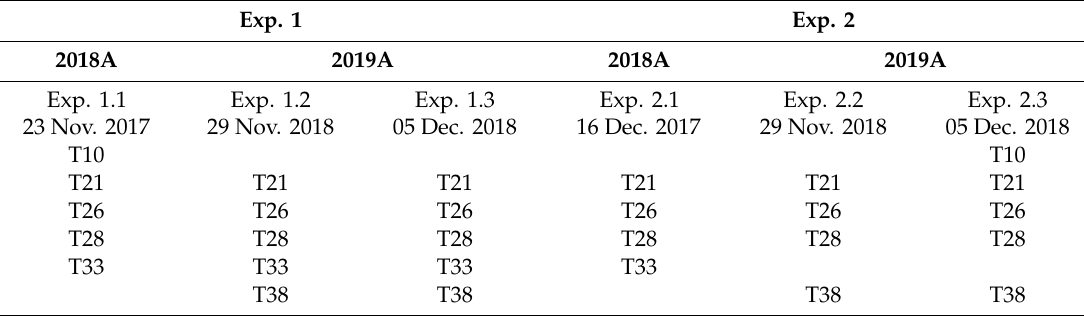
Table 2. First and second experiments, crop growth seasons, experiment number, sowing dates and lines